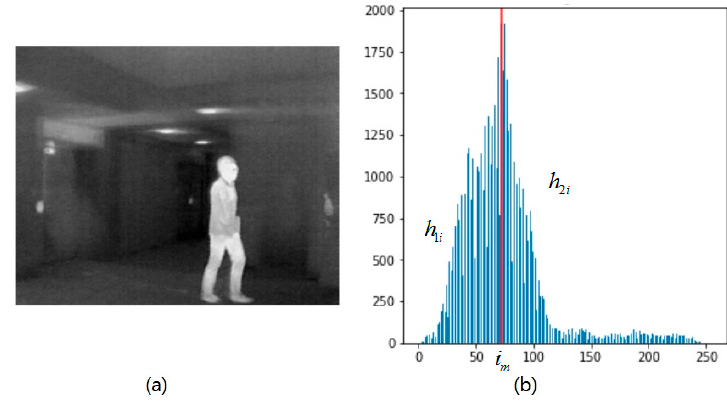
Figure 1. ( a ) Infrared image of a person; ( b ) grayscale histogram of the image.